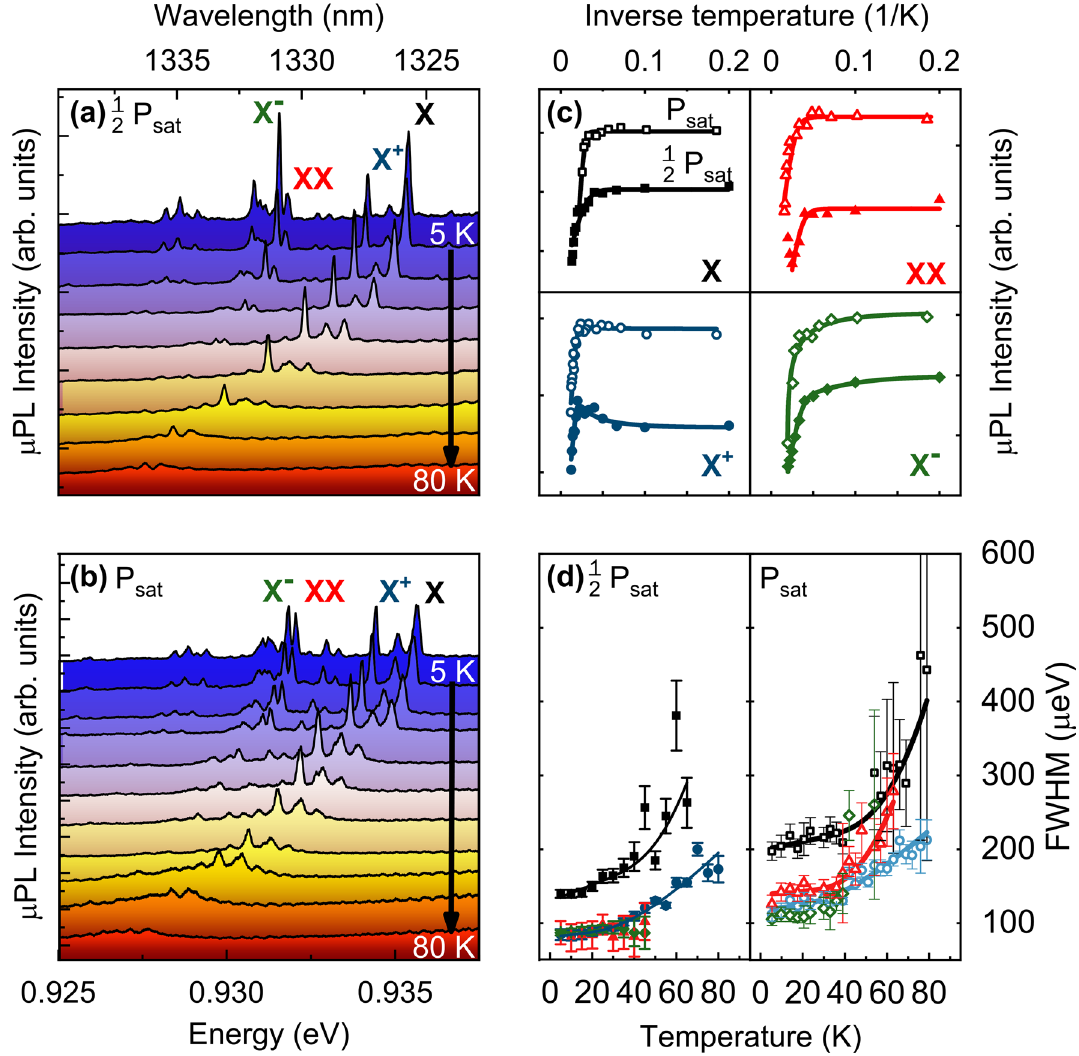
1 P sat ( a ) and P sat ( b ). Analysis of 2